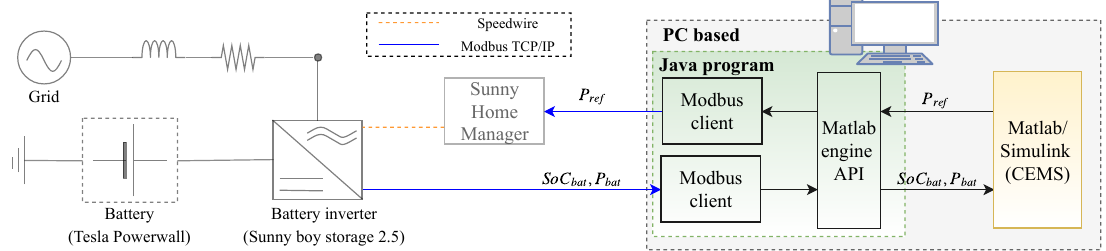
Figure 15. Laboratory setup for the validation of CEMS use case.